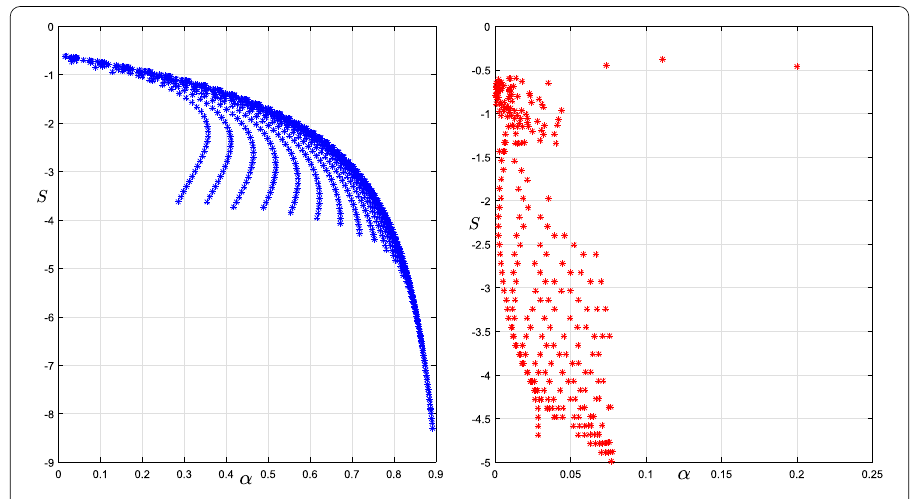
Figure 1 Relations between R e ( s ) and α when τ = 1 (left is det( (cid:7) ( s )) = 0, right is Eq.